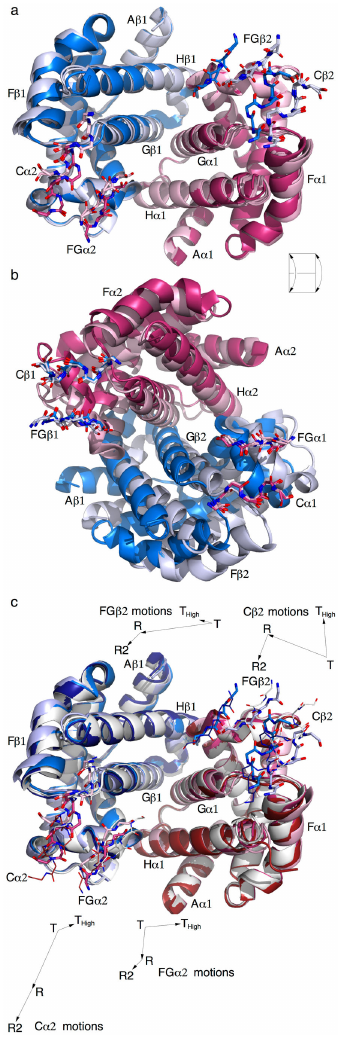
Figure 4. Back calculated structures by distance geometry. α and β are in warm and cool colors, respectively. Quaternary T state is in light pink and light blue. R is in median red and median blue. R2 is in dark red and dark blue. T is in High white. A ribbon model represents one dimer in background. The opposite dimer is then in stick model in foreground. T and R are in thick stick models. T and R2 are in thin stick High models. All structures are aligned by least-squares fitting of the invariant framework of α1β1 identified by the rmsd matrix (Figure S11a). a . Five structures are superimposed: Ttttt or 01, Trttt or 11, Trrtt or 21, Rrrrt or 31, and Rrrrr or 41. α1β1 is in background and α2β2 is in foreground. Movie S4 shows these structures in motion. b . Same as a except that α2β2 is in background and α1β1 is in foreground. The relation of viewpoints is indicated by a flip of the page. Movie S5 shows these structures in motion. c . Same view as in a . Four consensus structures are superimposed: T , T, R, and R2. High Some motions of α2β2 are also indicated by the inserted vector diagrams. The lengths of vectors are twice as long as the observed